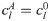
Results obtained with Generalized Gamma distribution.The panels are referred to in order from left to right, from top to bottom. Horizontal axis in each panel shows cl (clA=cl0 to be precise). The colored polygons in the first panel show the mean group difference (thick line) and its 95% CI (surface). The blue color shows results with log-transformed data while the red color shows results with raw data. The second panel shows Cohen’s d along with CIs. The layout is similar to the layout of the first panel. The third panel shows results of the TOST equivalence testing procedure. The vertical axis shows the proportion of cases which supported group equivalence. In the fourth panel, the vertical axis shows the probability of the hypothesis of group mean equivalence relative to the hypothesis of a group mean difference. The blue and the red color in the third and fourth panel designate whether the methods are applied to transformed or raw data. The vertical axis in the fifth and sixth panel shows the proportion of rejections of null hypothesis (group equivalence). Fifth panel shows results from t-test (red), log-t-test (blue), MW test (green) and trimmed t-test (yellow). The sixth panel show results from three-level-F-test with transformed data (blue) and raw data (red). The green line shows results of KW test. The values in panels one, two and four were obtained as median across replications.